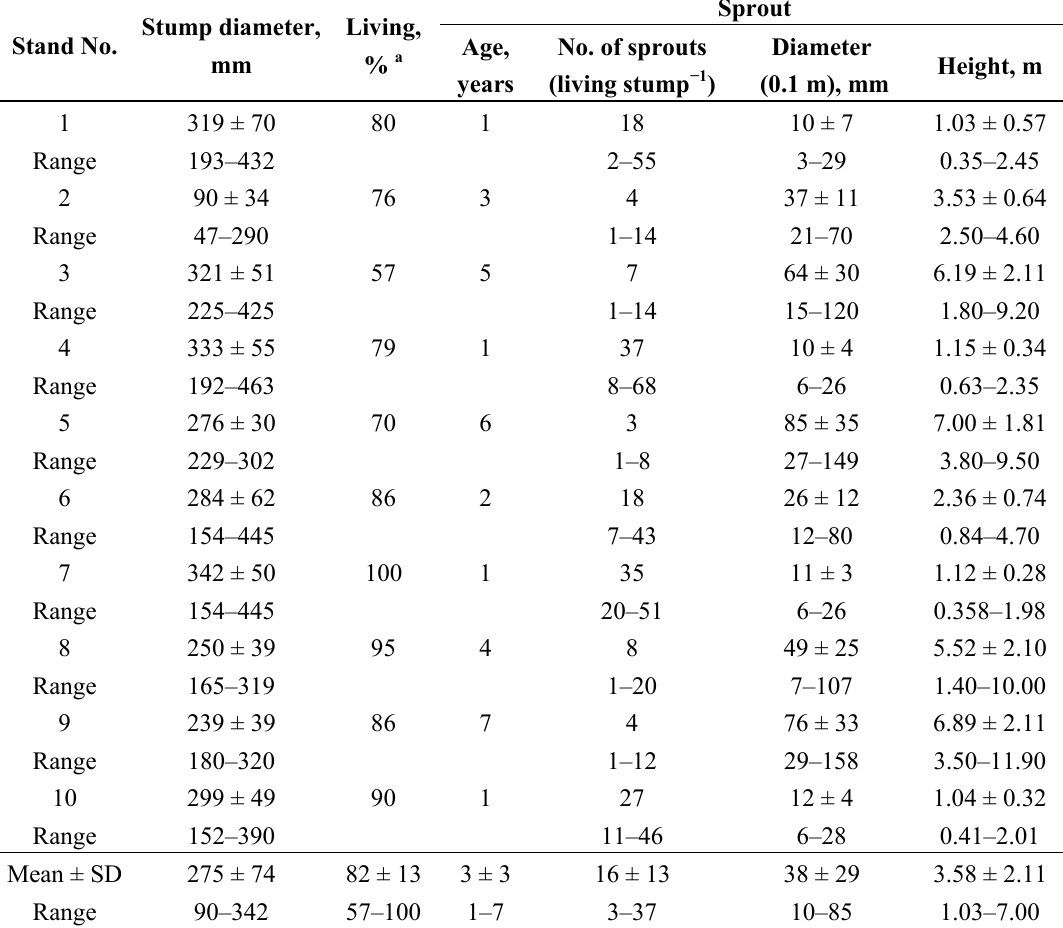
Table 2. Mean stump diameters and properties of the sampled stumps and